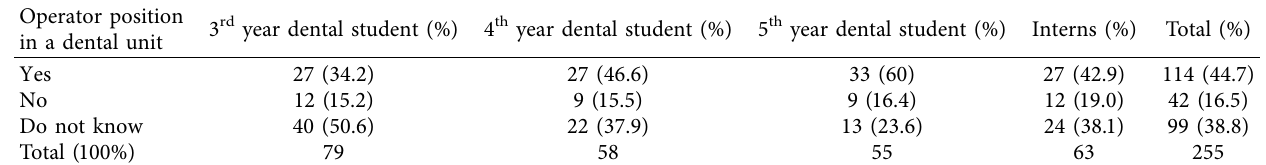
23.03 with P 0 . 01). (cid:31) ≤